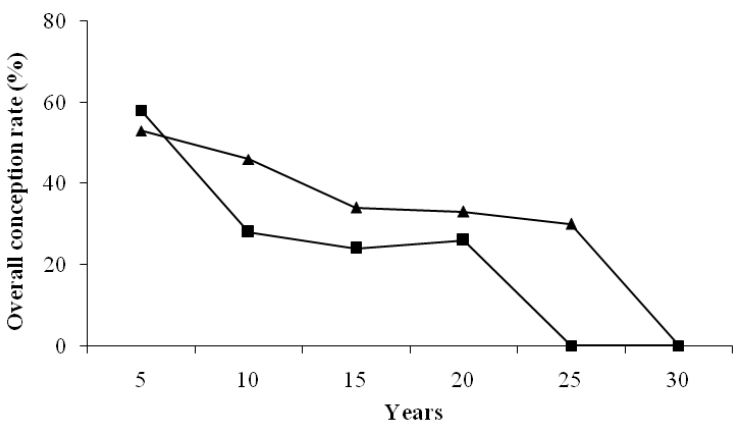
Figure 3. Overall conception rate (number of pregnant mares/number of mated mares) according to the mare’s age. Shown are the % of conception rates of Arabian ( n = 19) (▲) and Thoroughbred ( n = 26) (■)